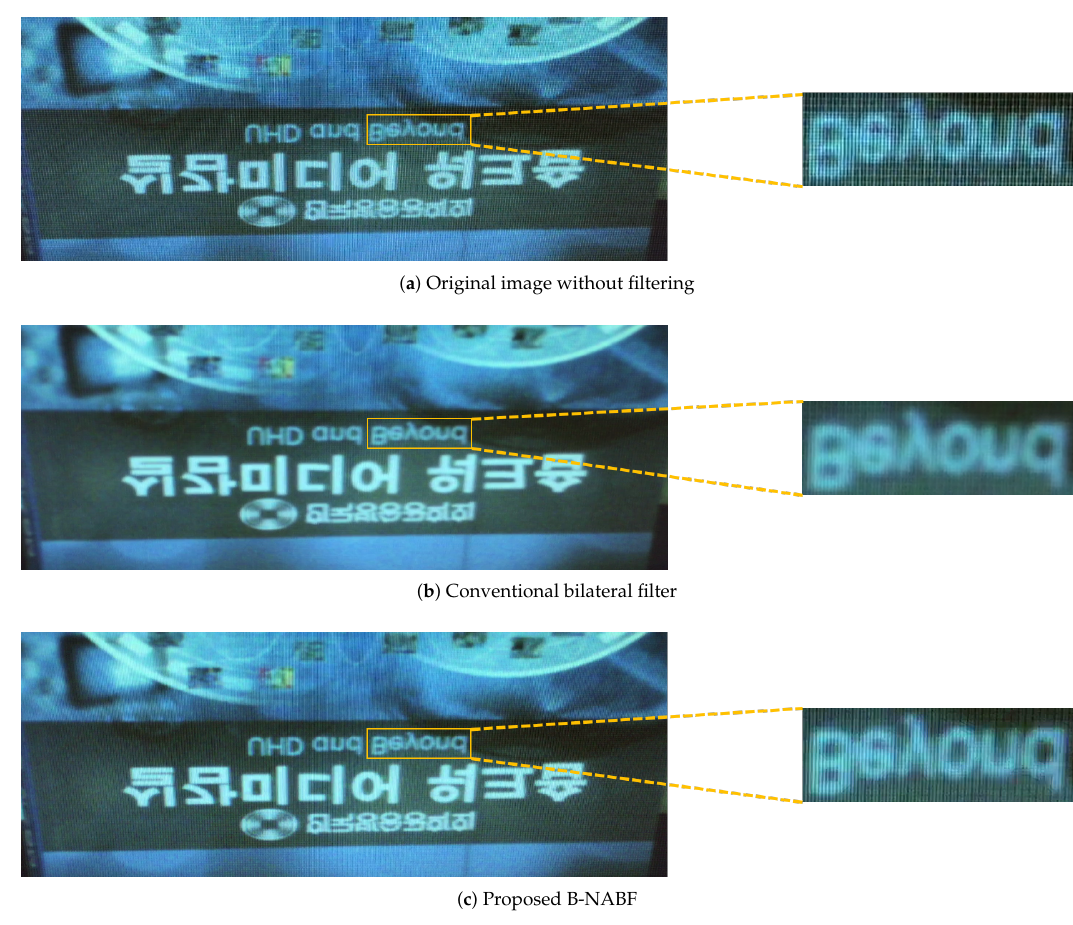
Figure 9. Filtered images by VLSI designs of the conventional bilateral filter and the proposed